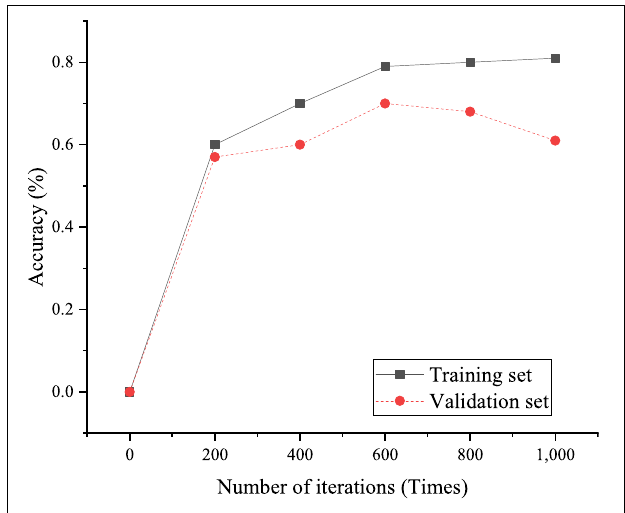
FIGURE 4 | Determination of model iteration times.